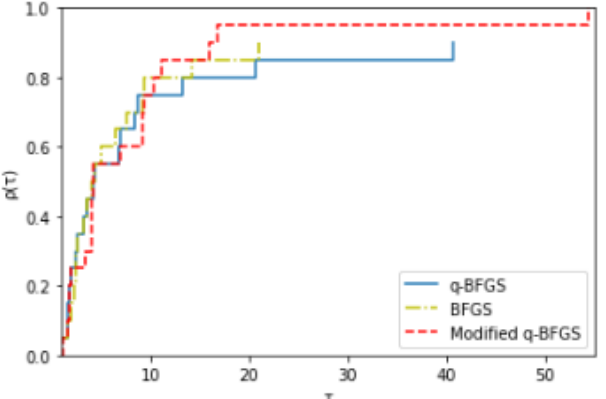
Figure 17. Performance Profile based on number of function evaluations.